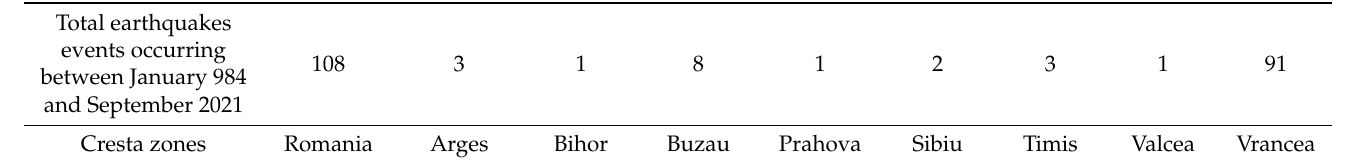
Table 3. The distribution of the events with a magnitude moment ≥ 6 that occurred in Romania in CRESTA zones (a total number of 108